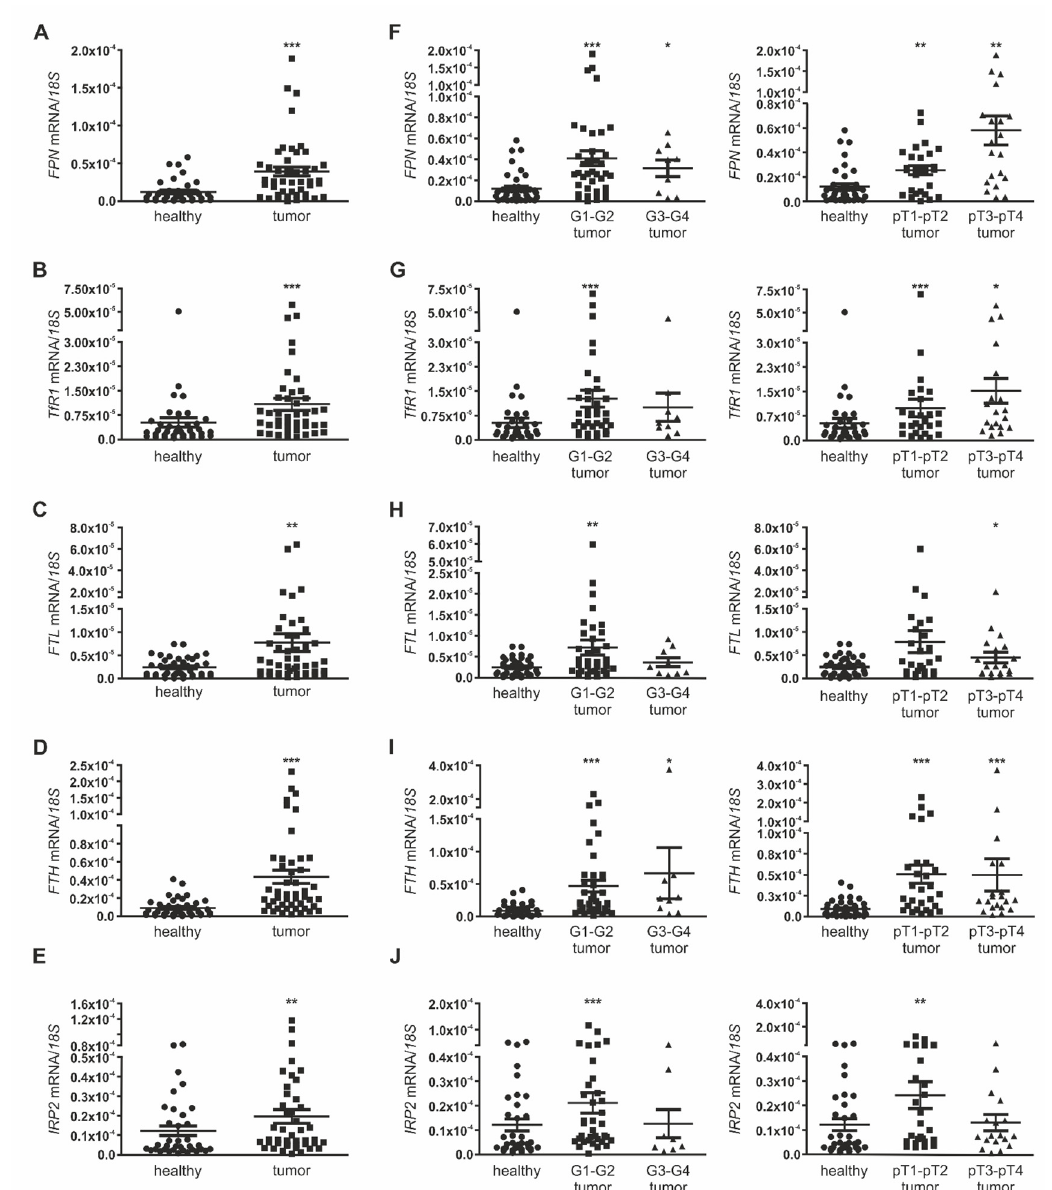
Figure 1. Expression of iron-regulated genes in human renal cancer samples. mRNA expression normalized to the housekeeping gene 18S in whole tissue homogenates of renal tumor tissue and adjacent healthy tissue of ( A ) FPN ( n = 48), ( B ) TfR1 ( n = 47), ( C ) FTL ( n = 48), ( D ) FTH ( n = 48), and ( E ) IRP2 ( n = 46). ( F – J ) Left: mRNA expression of ( F ) FPN , ( G ) TfR1 , ( H ) FTL , ( I ) FTH, and ( J ) IRP2 correlated to low (G1-G2) and high (G3-G4) tumor grade. Right: mRNA expression of ( F ) FPN , ( G ) TfR1 , ( H ) FTL , ( I ) FTH, and ( J ) IRP2 correlated to low (pT1–pT2) and high (pT3–pT4) tumor pT-stage. Number of tested patients differ between genes due to patients with failed measurements of initially low sample RNA amount. No samples have been excluded as outliers. Graphs are displayed as means ± SEM with * p < 0.05, ** p < 0.01, *** p < 0.001.